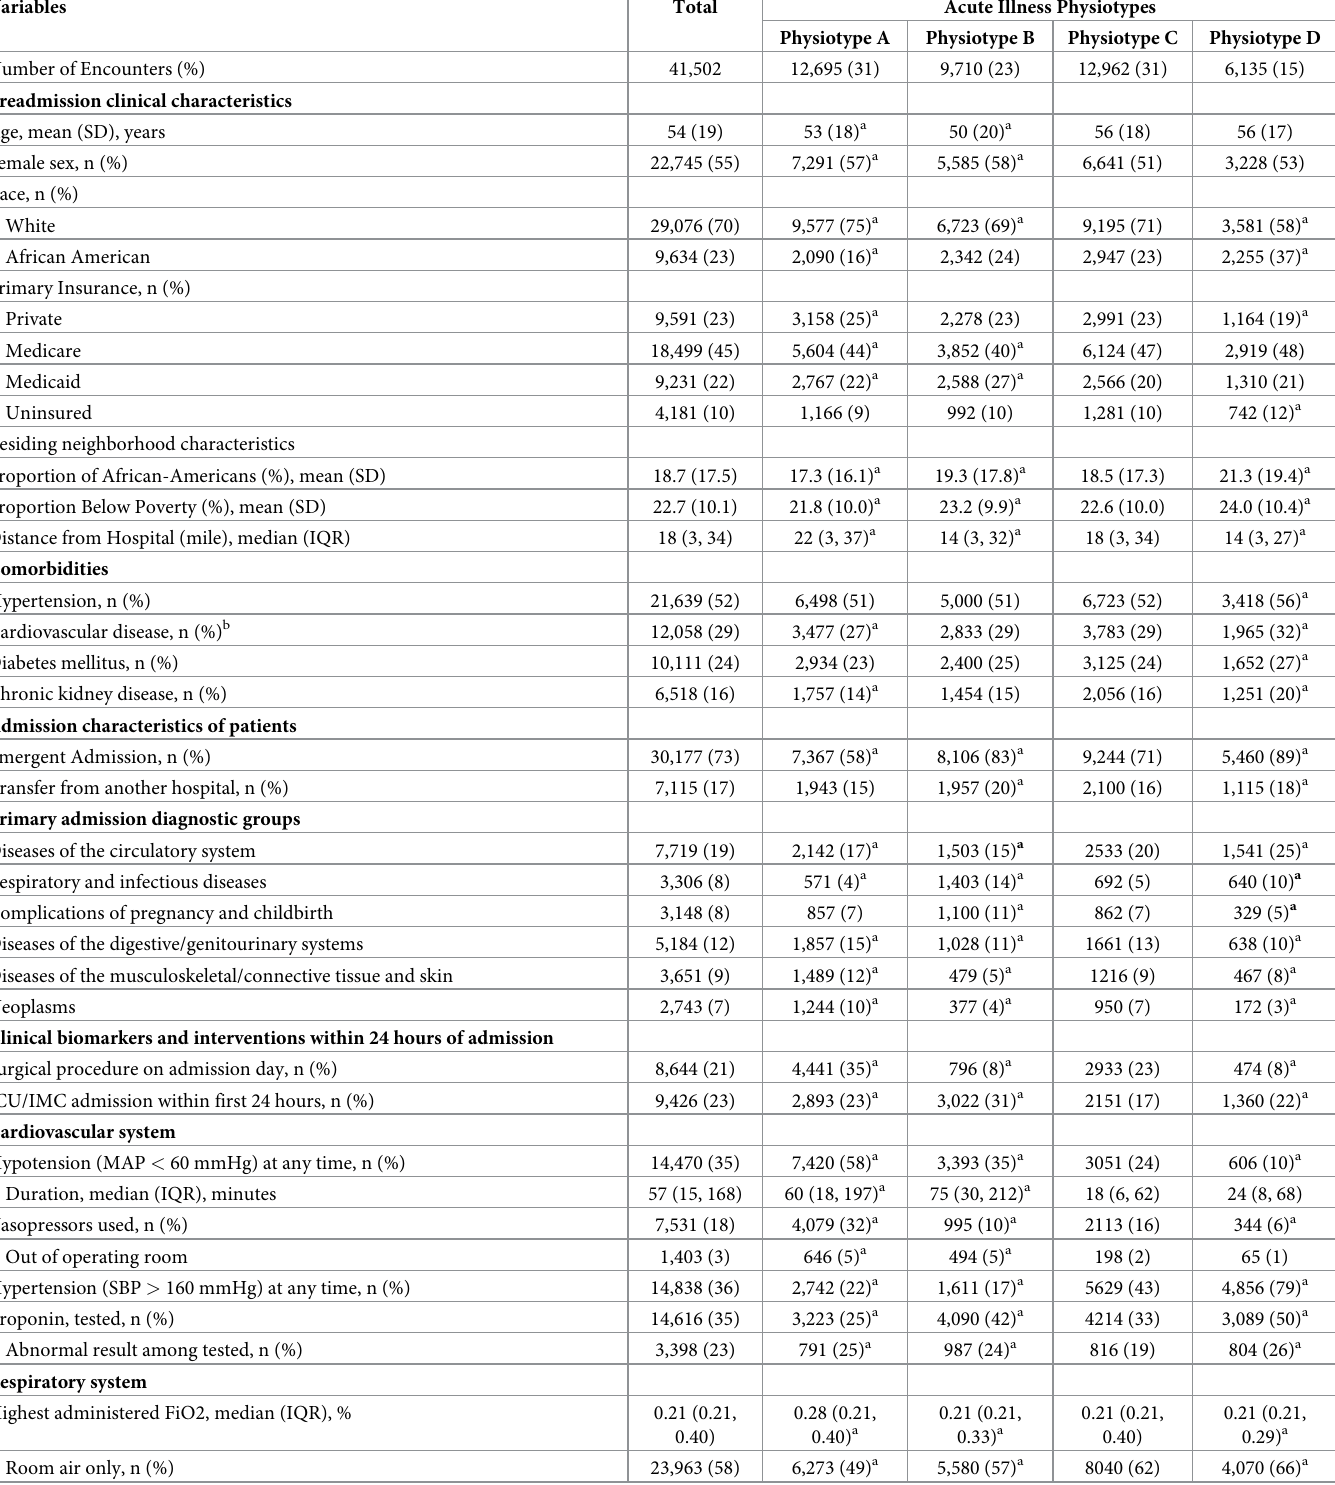
Table 1. Physiotype clinical characteristics and